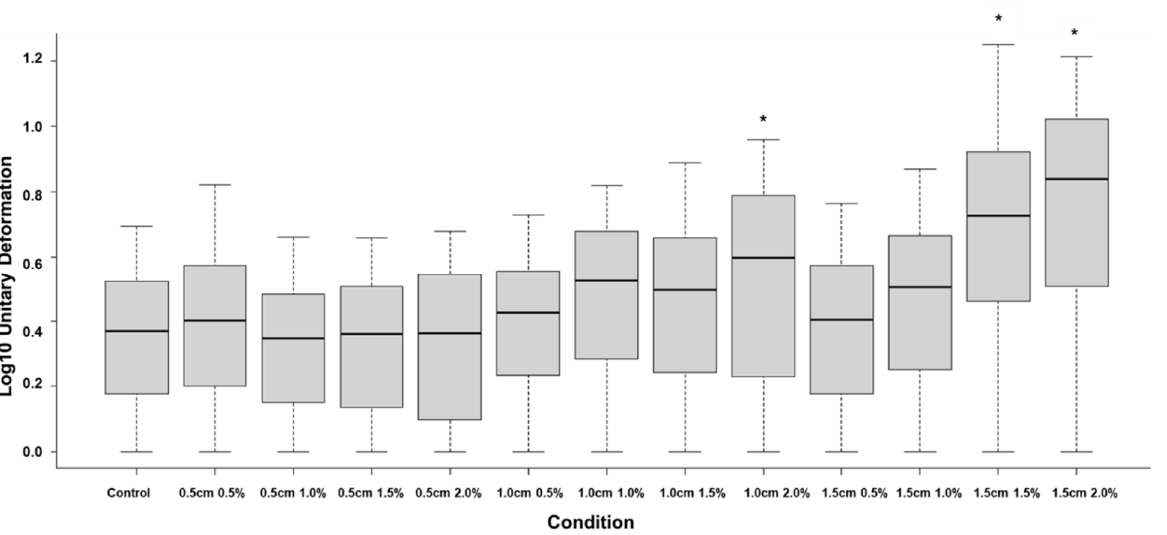
ues fell within a range of − 3 to 3 standard deviations.